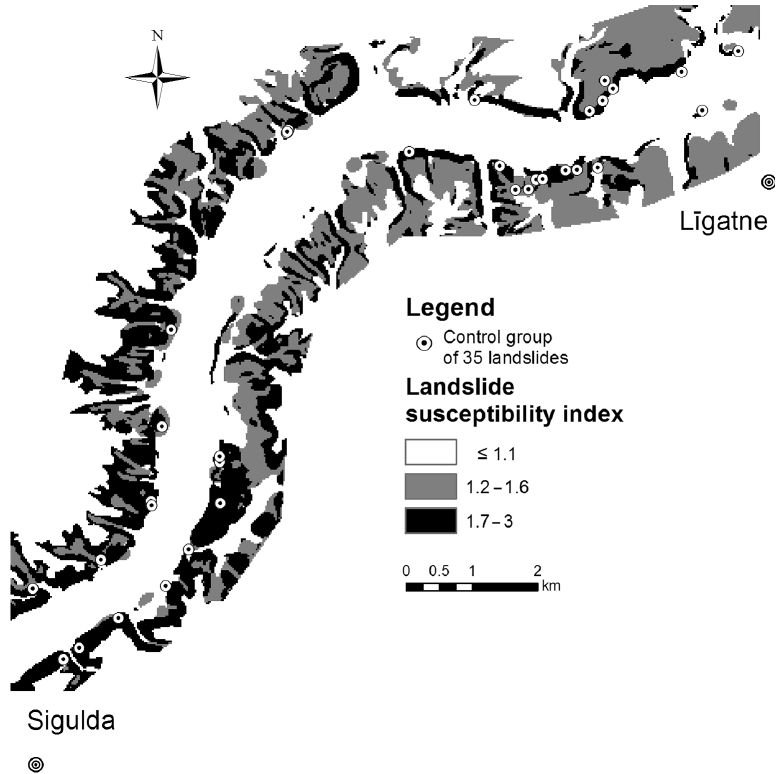
Fig. 8. Landslide susceptibility